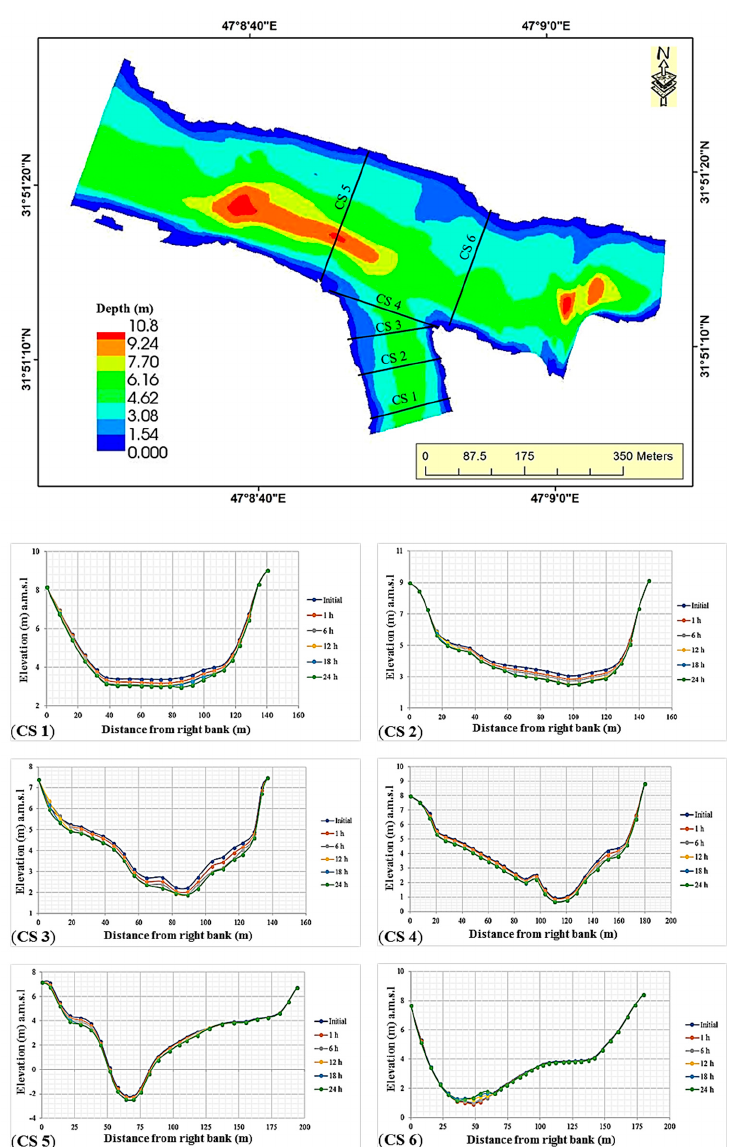
Figure 9. Depth simulation of the Tigris branching junction and profiles of simulated bed elevation (m) within 24 h at cross-sections CS 1, CS 2, CS 3, CS 4, CS 5, and CS 6.